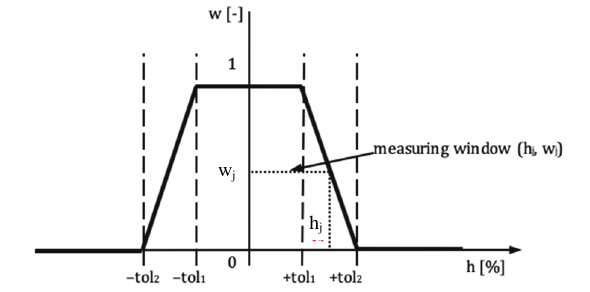
Fig. 4. Averaging window weighing function [1–4]